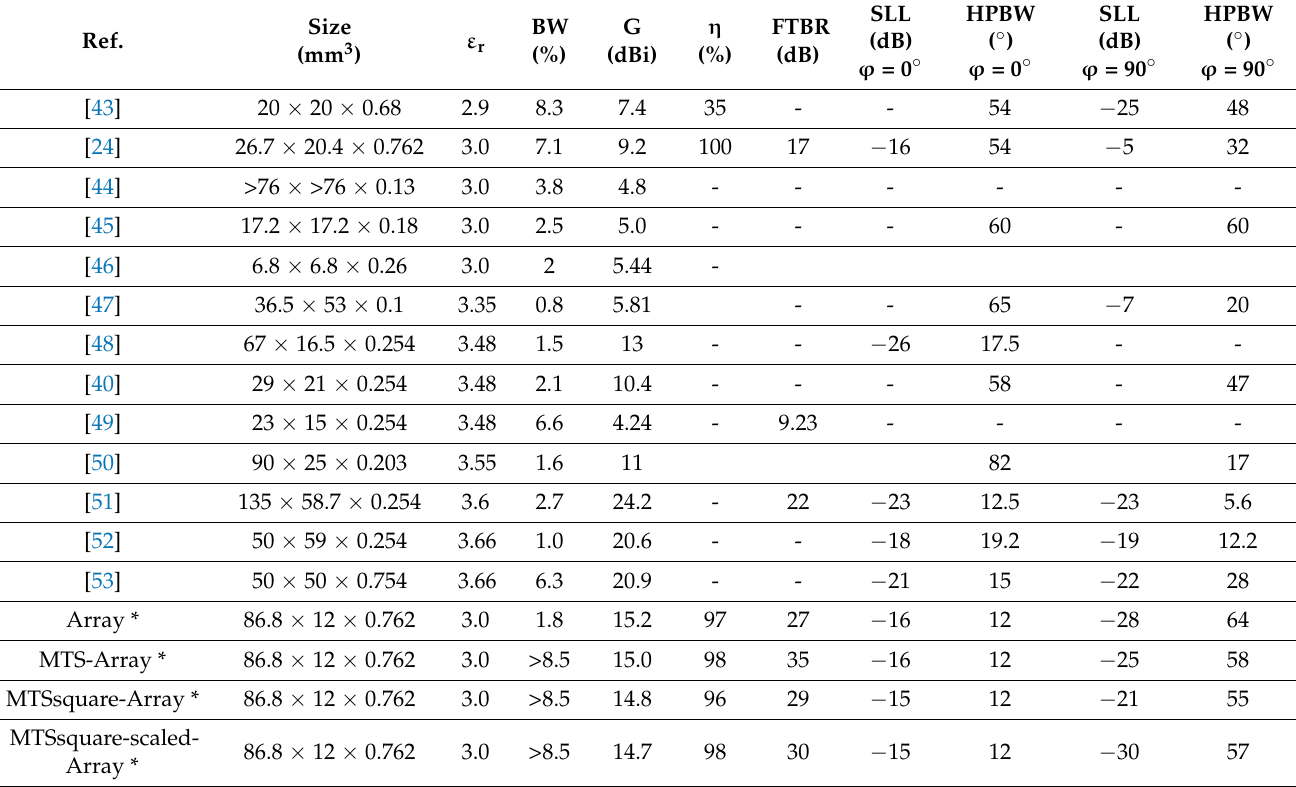
Table 3. Millimeter-wave antennas operating at 24 GHz radar